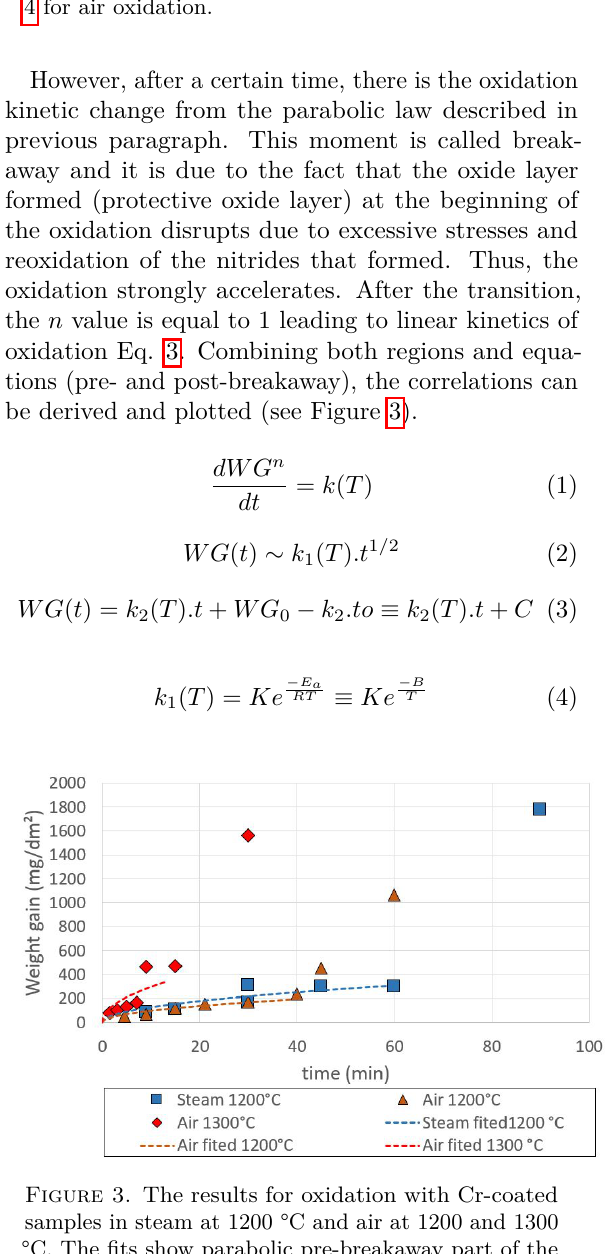
Figure 5. k as a function of 10000/T for Cr PVD coated and uncoated Optimized